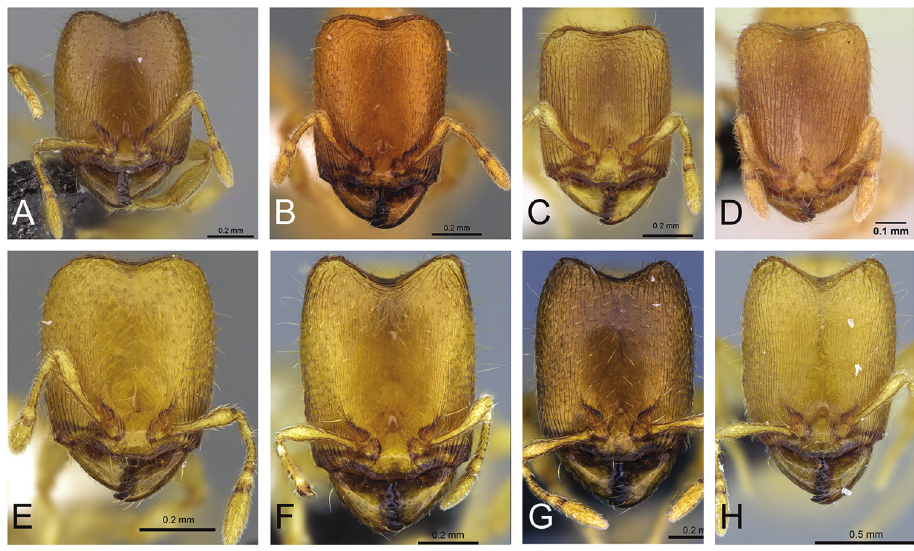
Figure 8. Head in full-face view of A Carebara omasi (CASENT0027898) B Carebara berivelo (CASENT0438188) C Carebara dota (CASENT0127649) D Carebara betsi (CASENT0479444) E Carebara salegi (CASENT0438150) F Carebara sampi (CASENT0030489) G Carebara vazimba